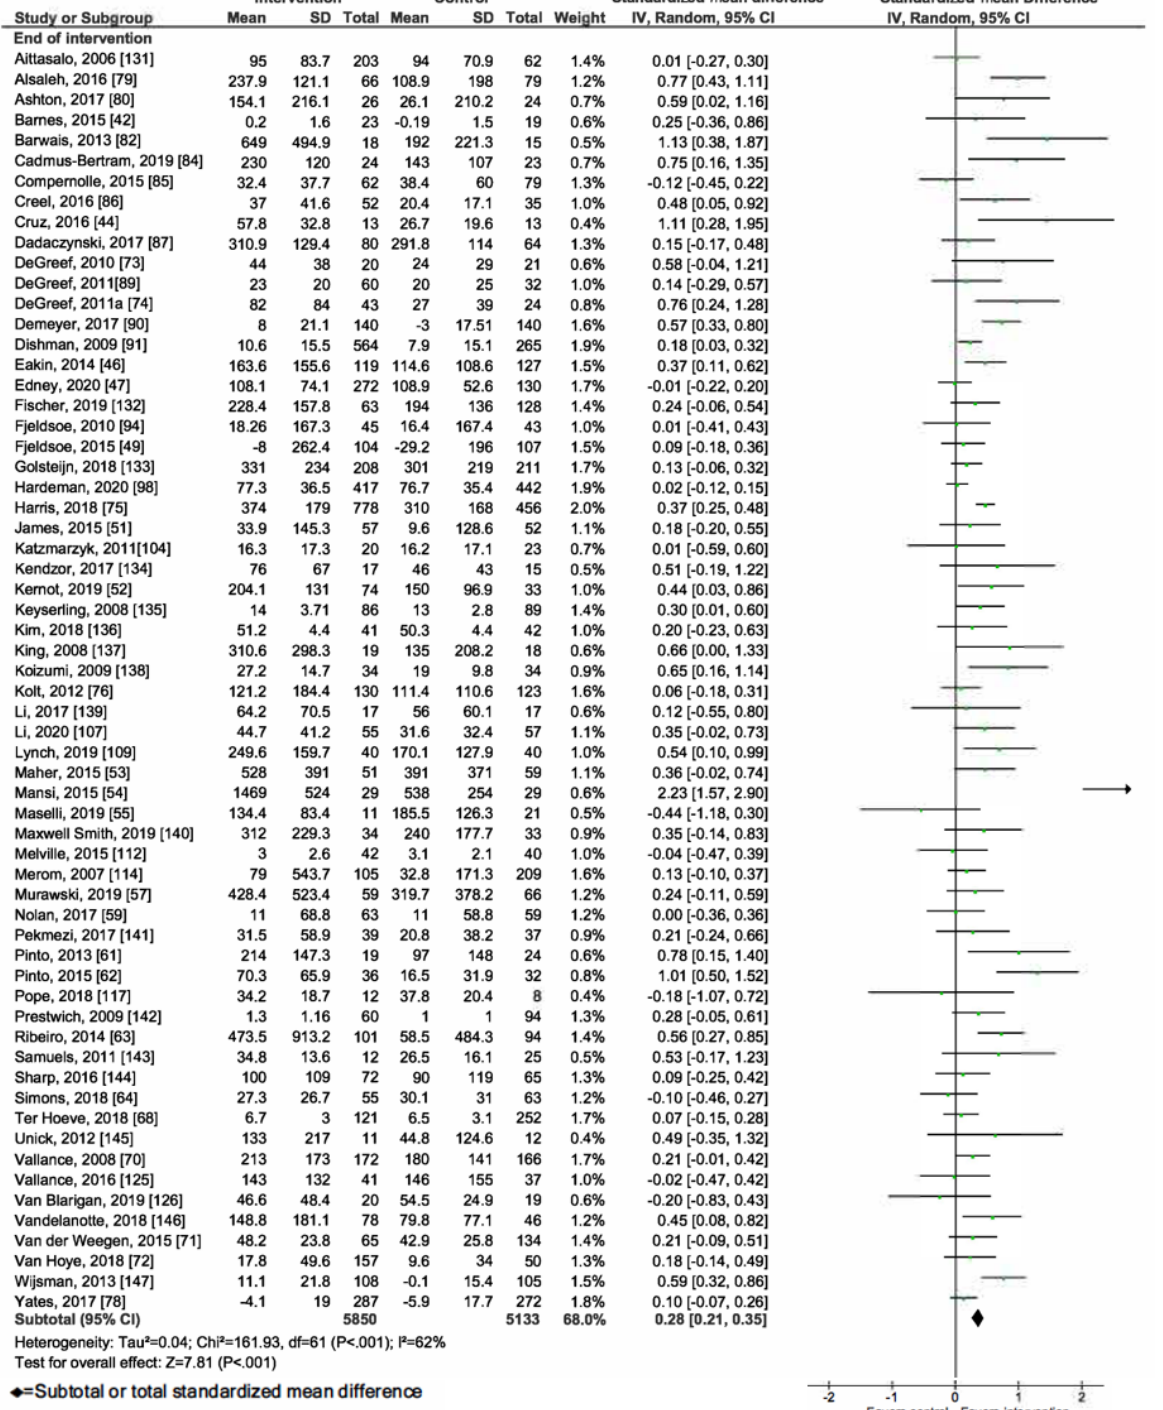
Figure 5. Primary outcome analysis for the outcome moderate-to-vigorous physical activity at timepoint end of